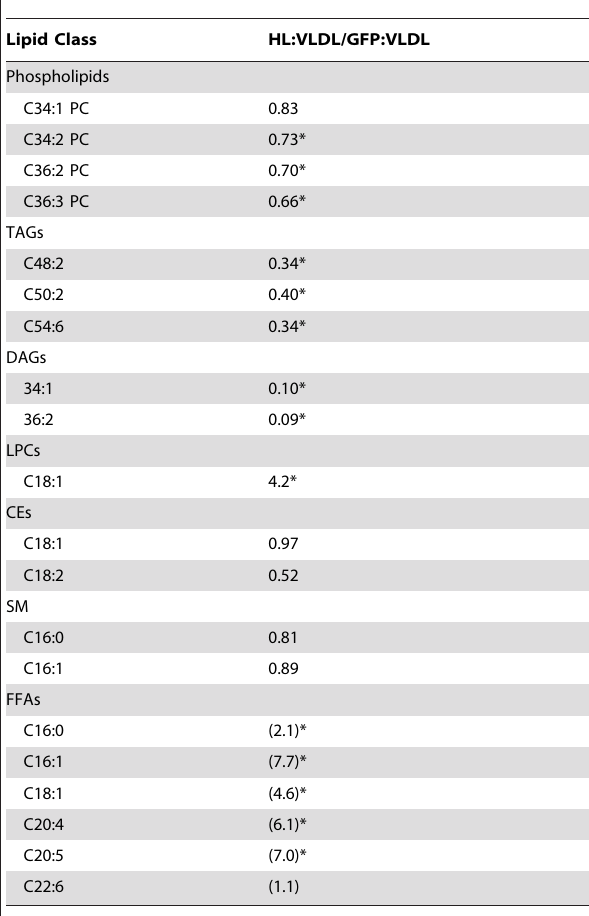
Table 1. Relative Levels of Representative Lipids Measured by Metabolite Profiling in Samples with HL:VLDL and GFP:VLDL a .